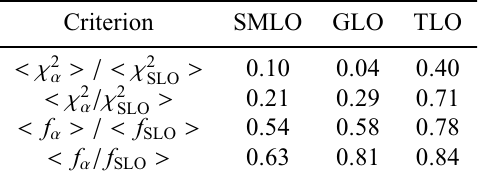
Table 1. The ratios of mean values of least-square deviation χ 2 and mean values of rms deviation factor f α for di ff erent E1 PSF models in relation to